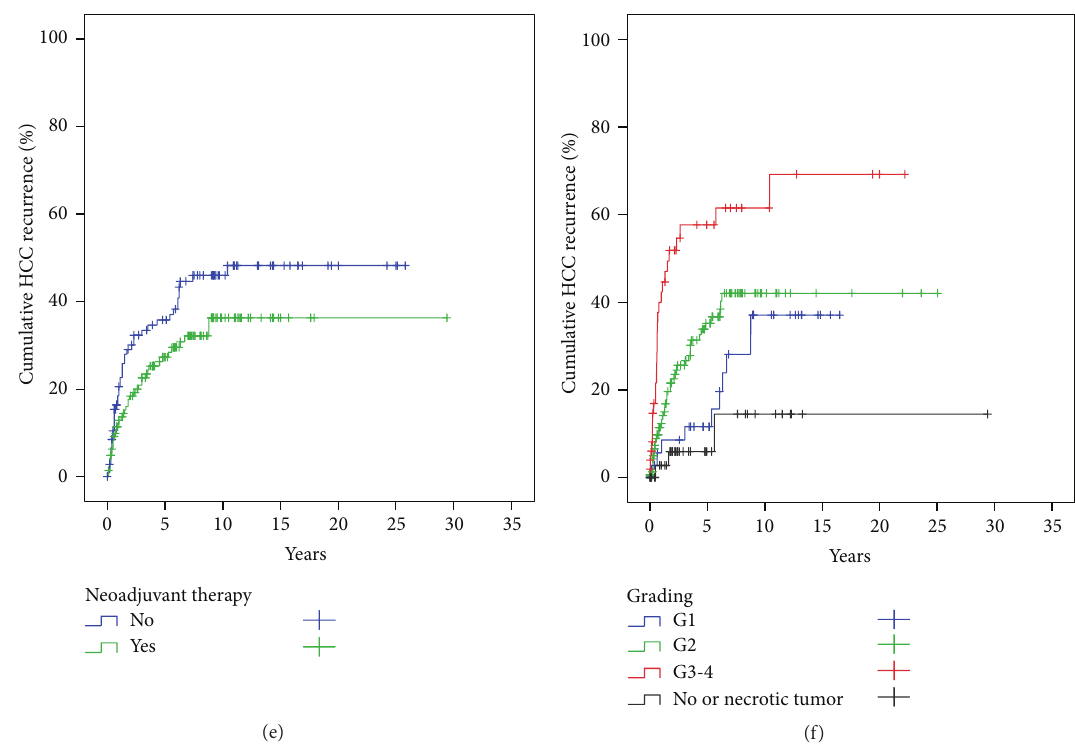
Figure 8: Cumulative recurrence of HCC (hospital mortality excluded) ( 𝑛 = 251 ) (for statistics see Table 3). (a) Underlying disease had no significant impact on HCC recurrence. (b) UICC-7 staging had a significant impact on HCCR. Only UICC I and II staged tumors were comparable to the reference category of no or necrotic tumors, while tumors of UICC-7 IIIA-IVB had significantly higher rates of HCCR. (c) The group of patients transplanted outside the histologic MILAN ( hMILAN ) had a maximum cumulative HCC recurrence rate of almost 70% at 10.4 years after LT, while patients transplanted inside hMILAN ( reference category ) only had a maximum cumulative HCC recurrence rate of about 25% at 7 years after LT. (d) Vascular infiltration was a highly significant predictor of HCC recurrence, while tumors without vascular infiltration had a comparable HCC recurrence rate compared to the reference group of no or necrotic tumors. (e) Neoadjuvant therapy had no significant impact on HCC recurrence. (f) Tumor grading was a significant hazard for HCC recurrence. G1 staged tumors had a comparable risk for HCC recurrence to the reference category ( no or necrotic tumors ), while G2 and G3-4 staged tumors were strong significant hazards for HCC